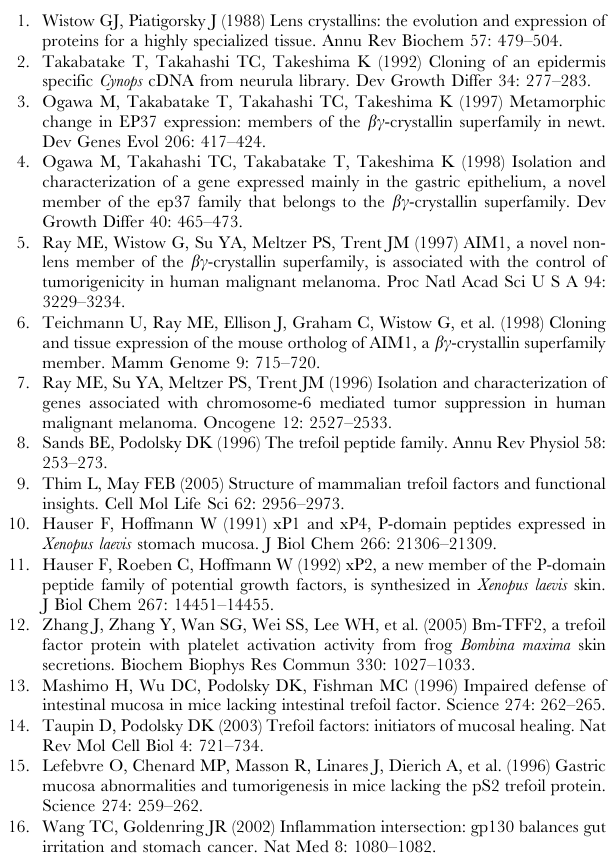
Figure S1 Hierarchical clustering of all significantly differential expression genes of HUVECs induced by betagamma-CAT. Four